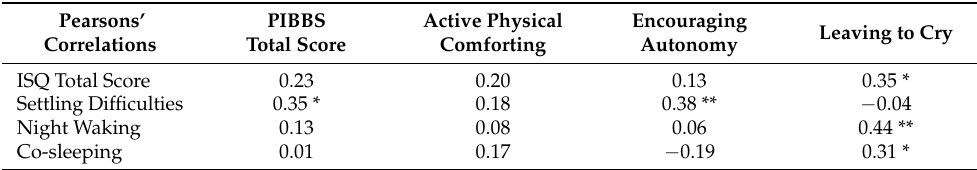
Table 3. Correlations between Late Talkers’ Perceived Night Sleep Characteristics and Parental Bedtime Practices. Pearsons’ PIBBS Active Physical Encouraging Leaving to Cry Correlations Total Score Comforting Autonomy